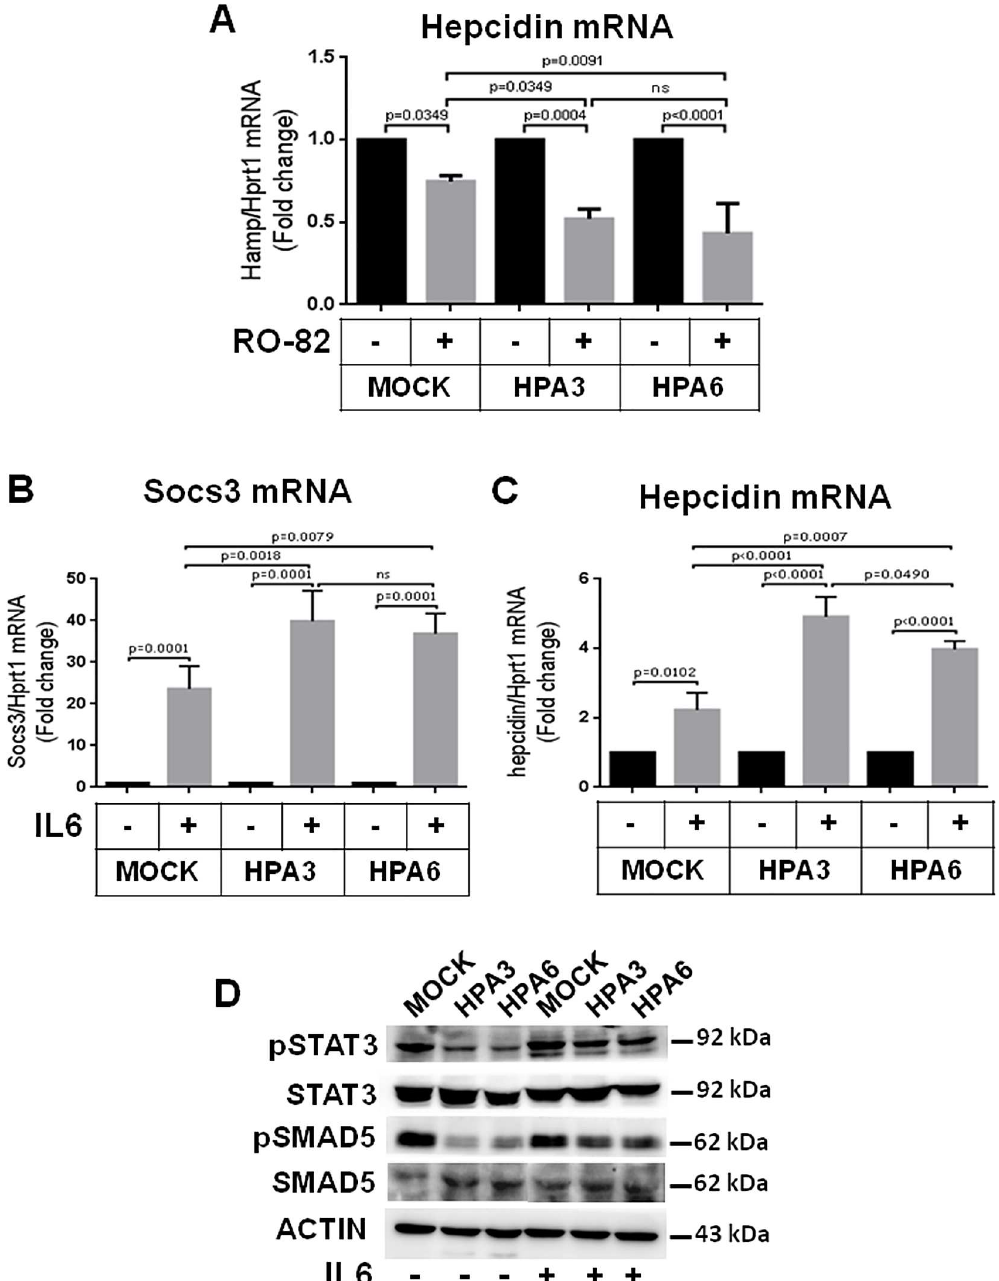
Fig 3. Treatment with heparin and IL6 of HepG2 clones overexpressing heparanase. (A) The two HepG2 clones overexpressing HPA (HPA3 and HPA6) and control (MOCK) cells were treated with 0.12 μ g/mL of RO-82 heparinfor 6 h and hepcidin mRNA evaluated.(B) The clones and control cells were treated with 50 ng/mL IL6 for 3 h and analyzedfor mRNA level of Socs3 and (C) hepcidinin relation to Hprt1. The values are expressed as fold change of their respective untreated controls (-). (D) Western blot of pSMAD5, total SMAD5, pSTAT3, total STAT3 and of ACTIN as housekeeping.